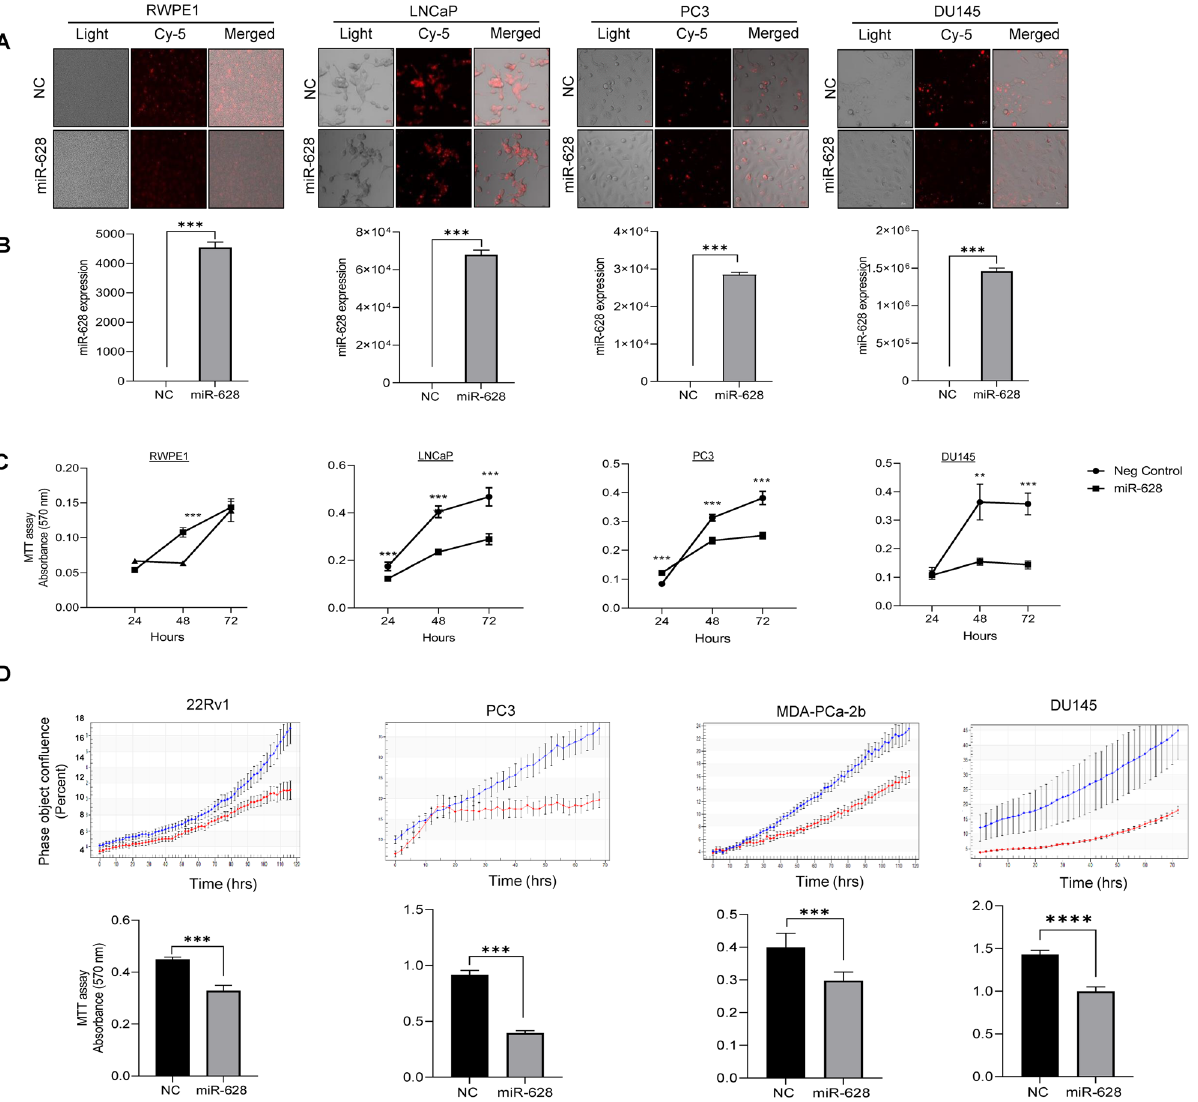
Figure 3. Overexpression of miR-628 affects PCa cell proliferation. ( A ) Cy-5 labeled miR-628 mimic or NC (100 nM) was transiently expressed in RWPE-1 and PCa cells. Effective transfection was visualized using immunofluorescence (red). Images were captured under Zeiss confocal microscope and representative images are shown at 20 × magnification. ( B ) Transfection efficiency of both miR-628 and NC was confirmed through RT/qPCR (***p < 0.001). ( C ) The effects of overexpression of miR-628-5p expression on cell proliferation were assessed through MTT assay in RWPE-1 cells or in PCa cells transfected with 100 nM of miR-628 mimic or NC for 24, 48, and 72 h (**p < 0.01, ***p < 0.001). ( D ) Live cell analysis was performed by using Incucyte in PCa cells transfected with 100 nM of miR-628-5p mimic (red line) or NC (blue line) for 72 or 120 h (upper panels). Results were further confirmed with MTT assay (lower panels). At the end of the selected period, absorbance was read at 570 nm (***p < 0.001). Data represent average ± SEM. Experiments were performed in